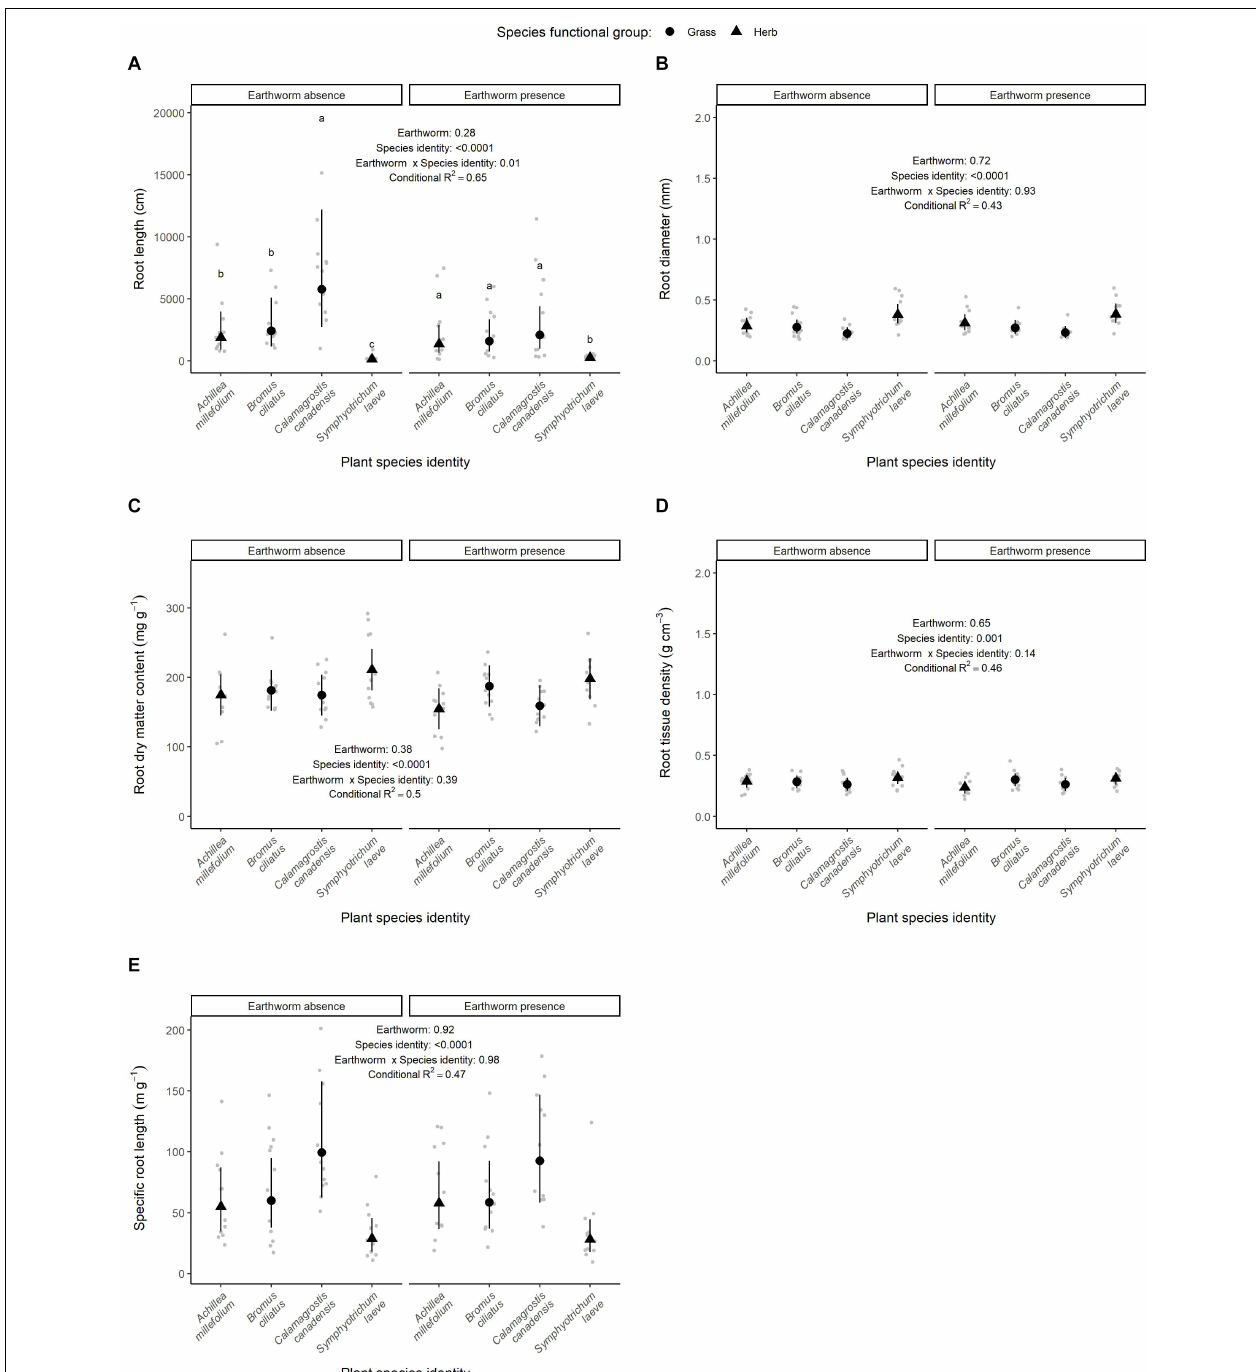
FIGURE 6 | Effect of earthworm presence on root length (A) , root diameter (B) , root dry matter content (C) , root tissue density (D) , and specific root length (E) . Estimated marginal means and confidence intervals are shown in black (after being back-transformed), while data points were included in the background in gray. The conditional R 2 as well as the p -values for each factor are based on linear mixed effect models. When the interaction between earthworm treatment and species identity were significant, post hoc test results are also presented: different letters show significant differences among species within each earthworm treatment. Number of observations per species and treatment: